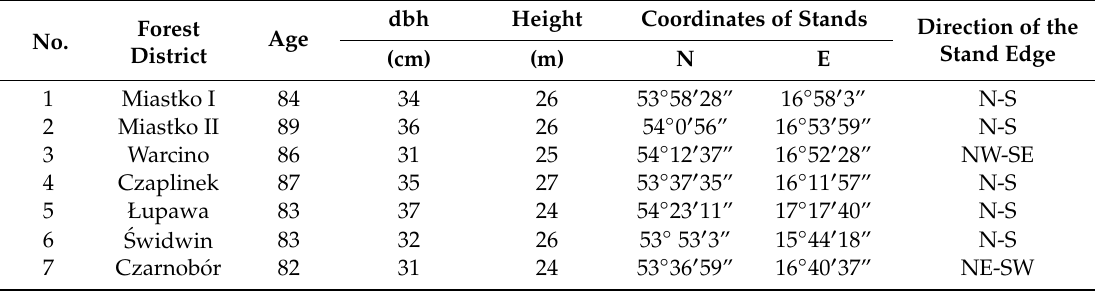
Table 1. Characteristics of stands, in which mean sample plots were